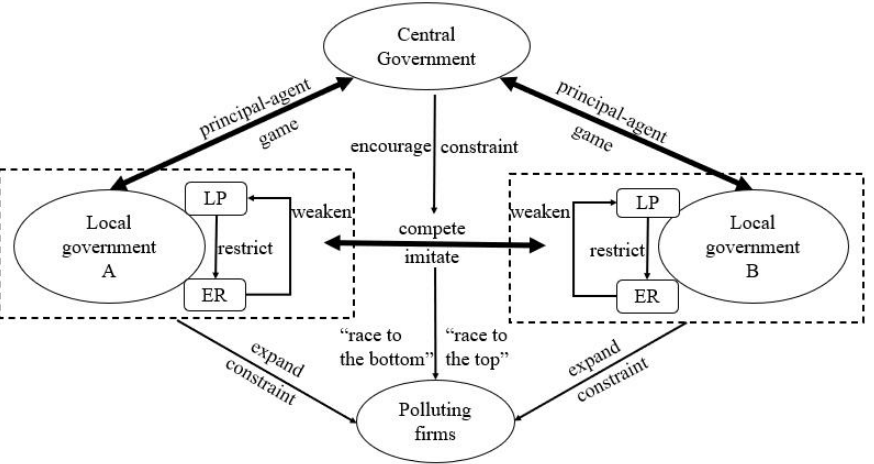
Figure 1. The interaction mechanisms between LP and ER.